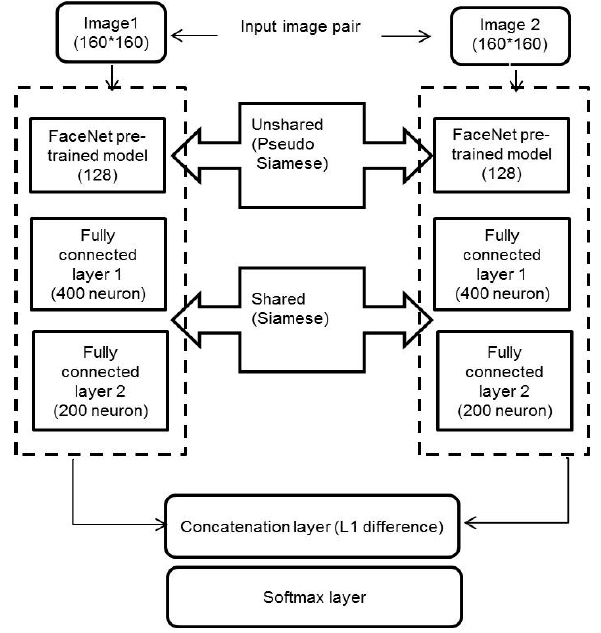
Figure 3. Hybrid Siamese network architecture.